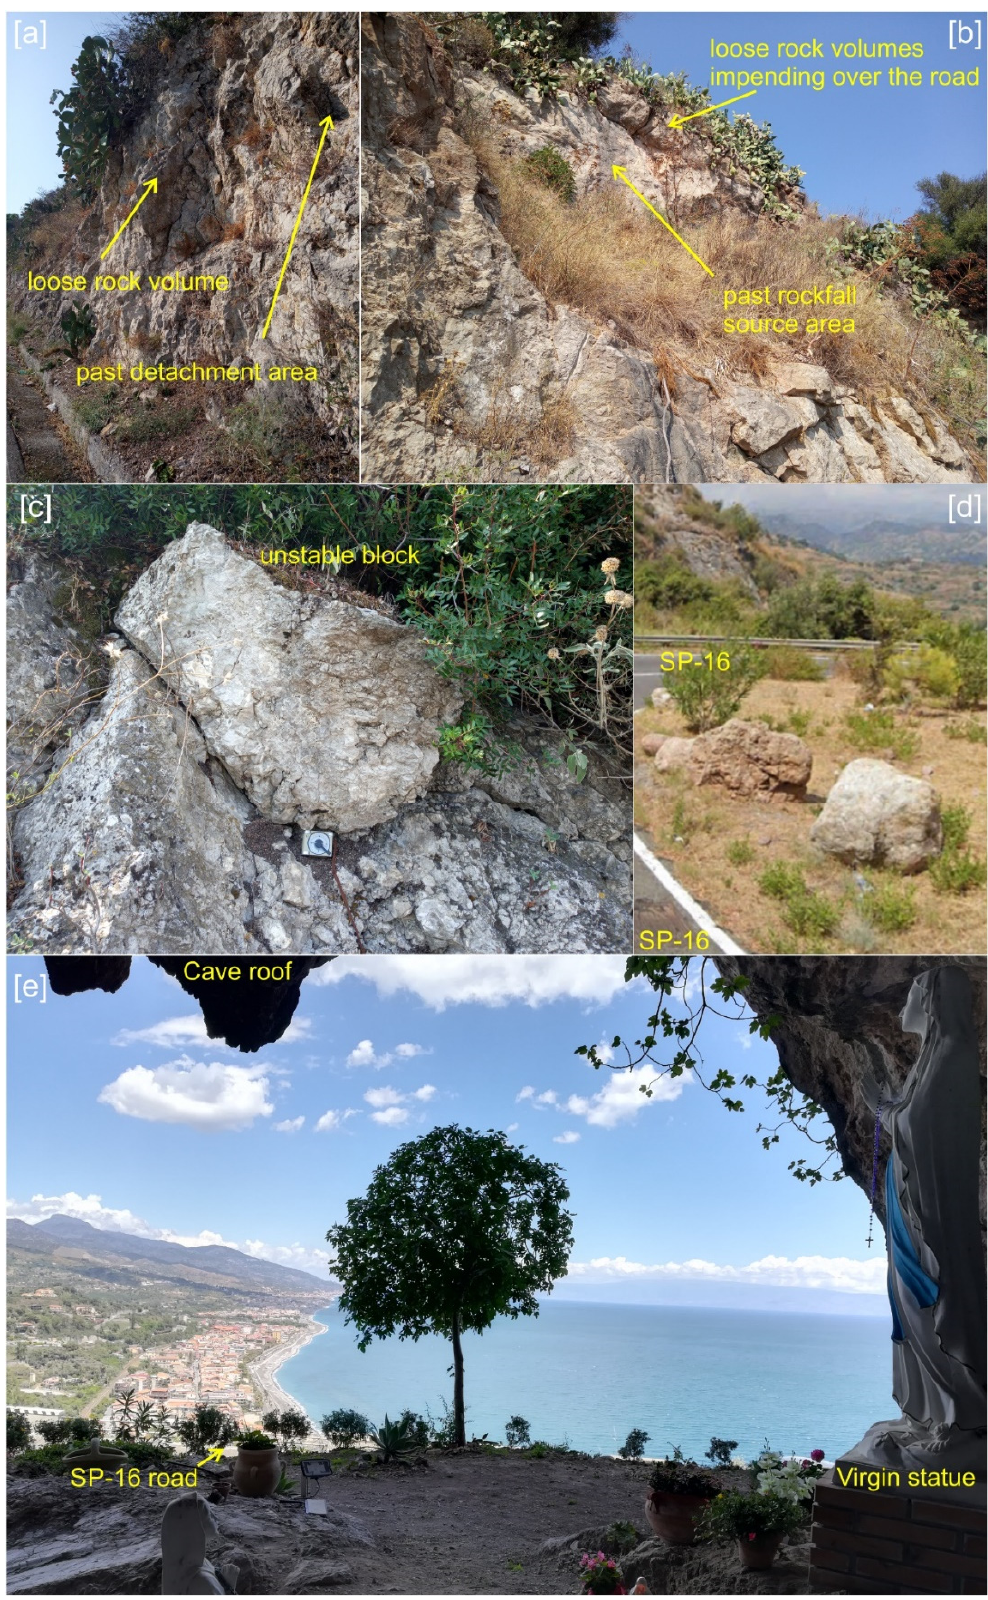
Figure 2. ( a , b ) Examples of rock masses hanging over the road and showing features of instability and past rockfall source areas; ( c ) previously fallen blocks surveyed at a road bend segment; ( d ) unstable block hanging over the road; ( e ) panoramic view from inside the religious cave.